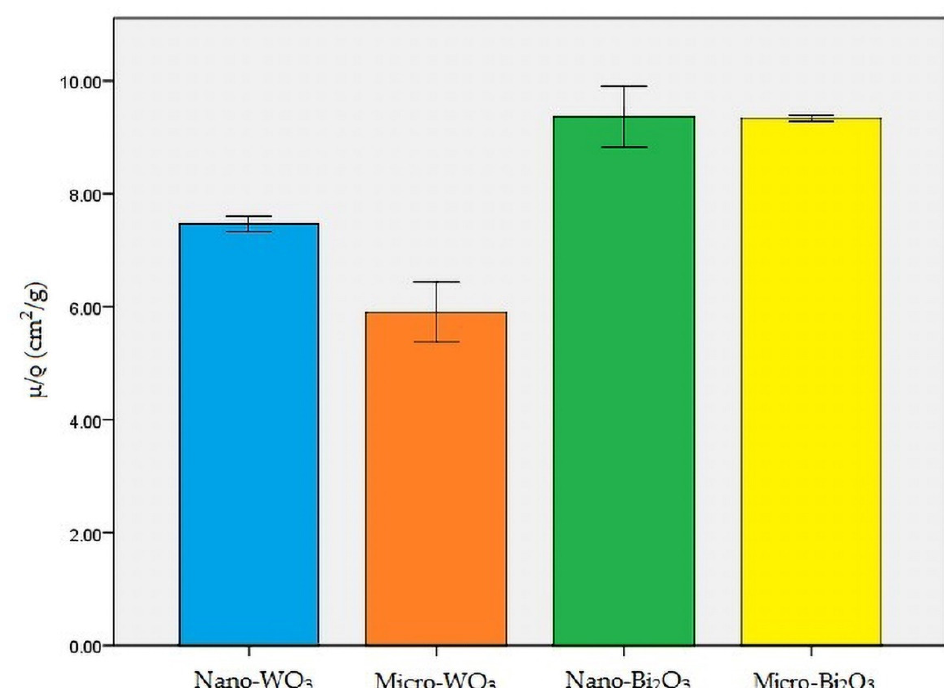
Figure 4. Linear attenuation coefficient (µ) of all the samples.